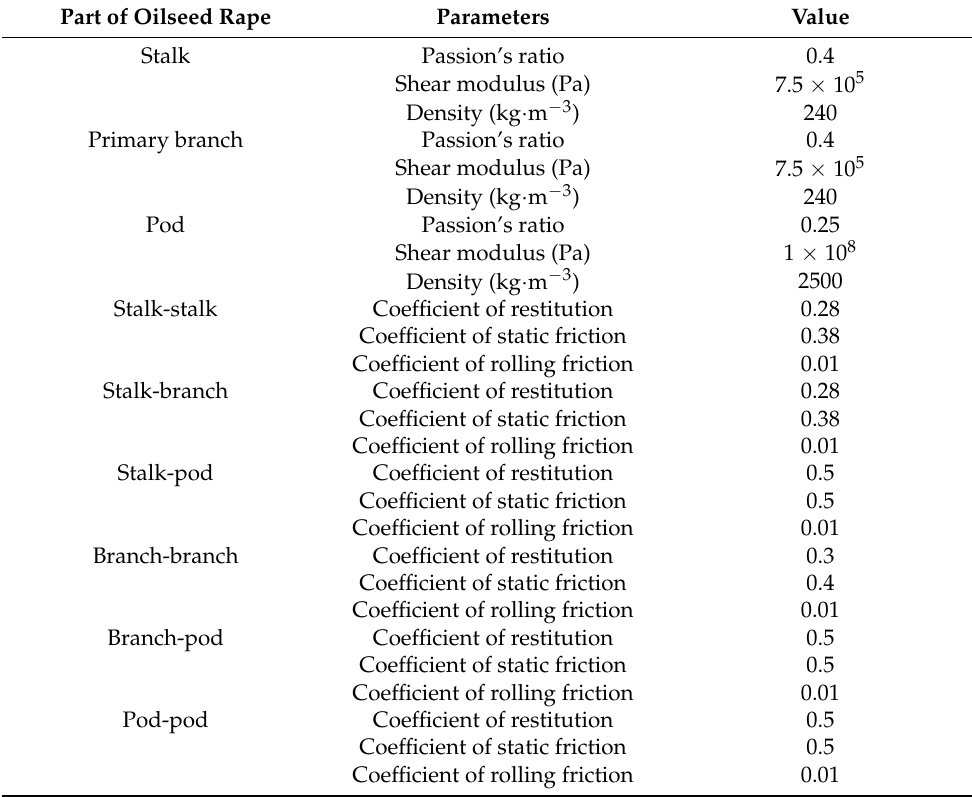
Table 2. Mechanical properties of the oilseed rape [30–33].